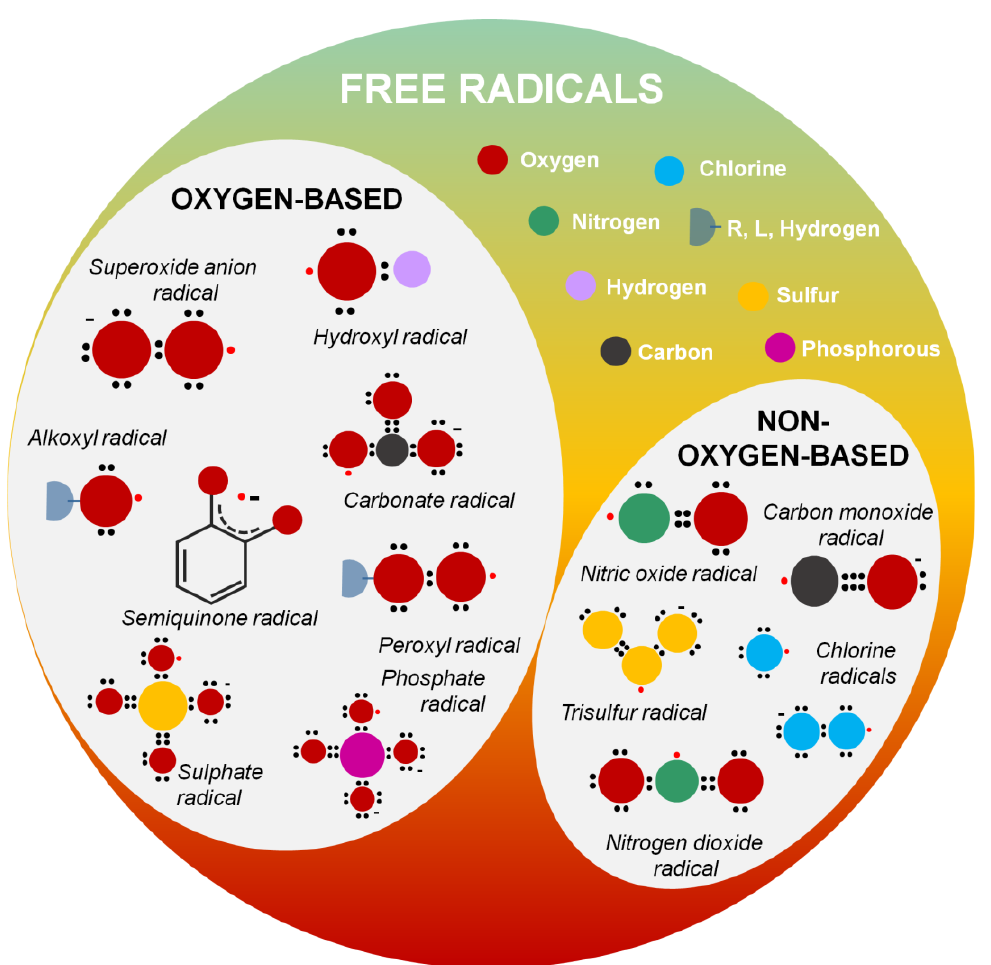
Figure 4. Free radicals are highly reactive species. It is a general term that describes species that bear at least one unpaired electron and includes oxygen-centered (some of the ROS) and non-oxygen- centered radicals such as nitrogen-centered (some of the RNS), carbon-centered, sulfur-centered, phosphorous-centered, and halogen-centered structures. Antioxidants counterbalance the severe cell damage when free radicals react with biological molecules.